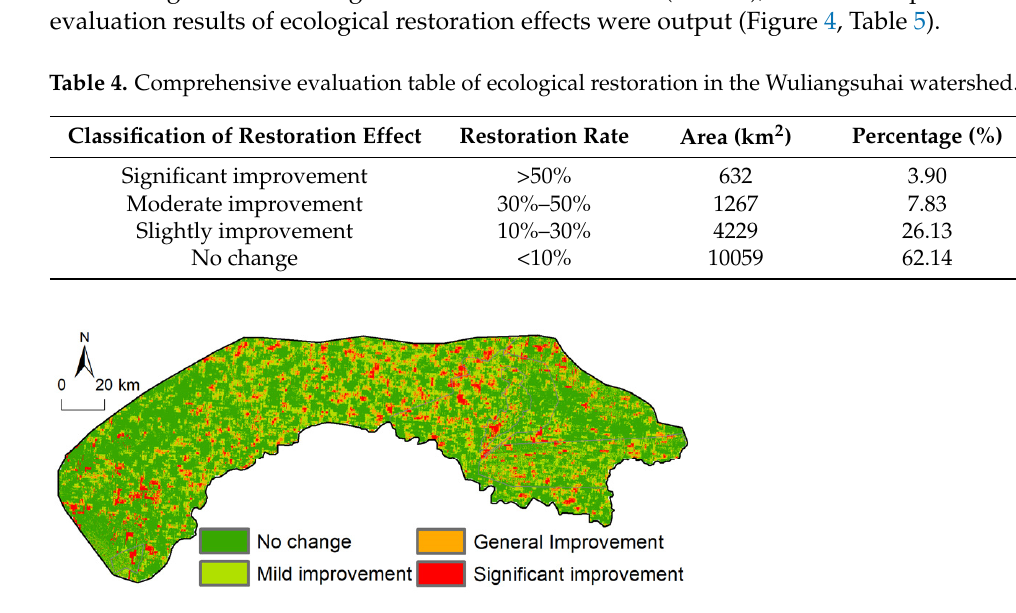
Figure 4. Comprehensive evaluation map of ecological restoration effect in the Wuliangsuhai watershed. Table 5. Comprehensive evaluation of ecological restoration in each treatment area of the Wuliang- suhai watershed (unit: km 2 ).